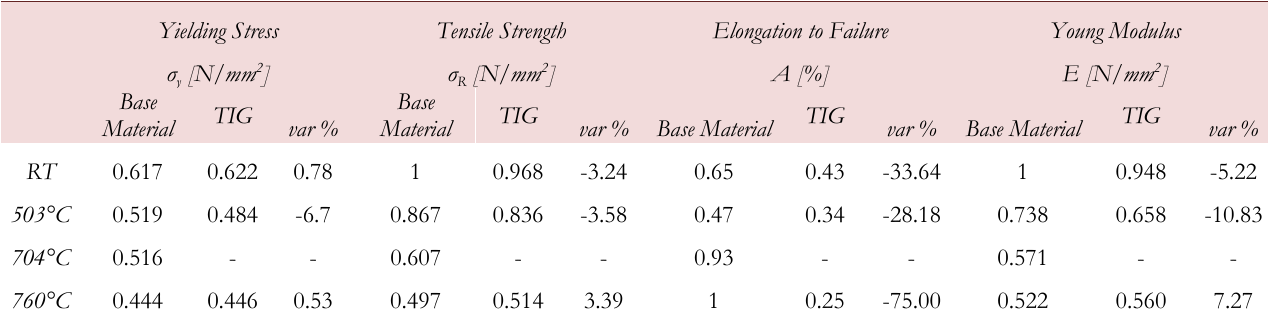
Table 1: Static behaviour of base and TIG welded